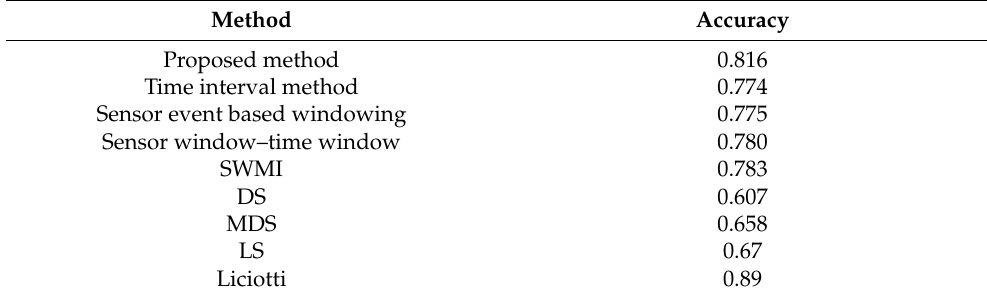
Table 4. Comparison results of classification using different neural network architectures and different segmentation